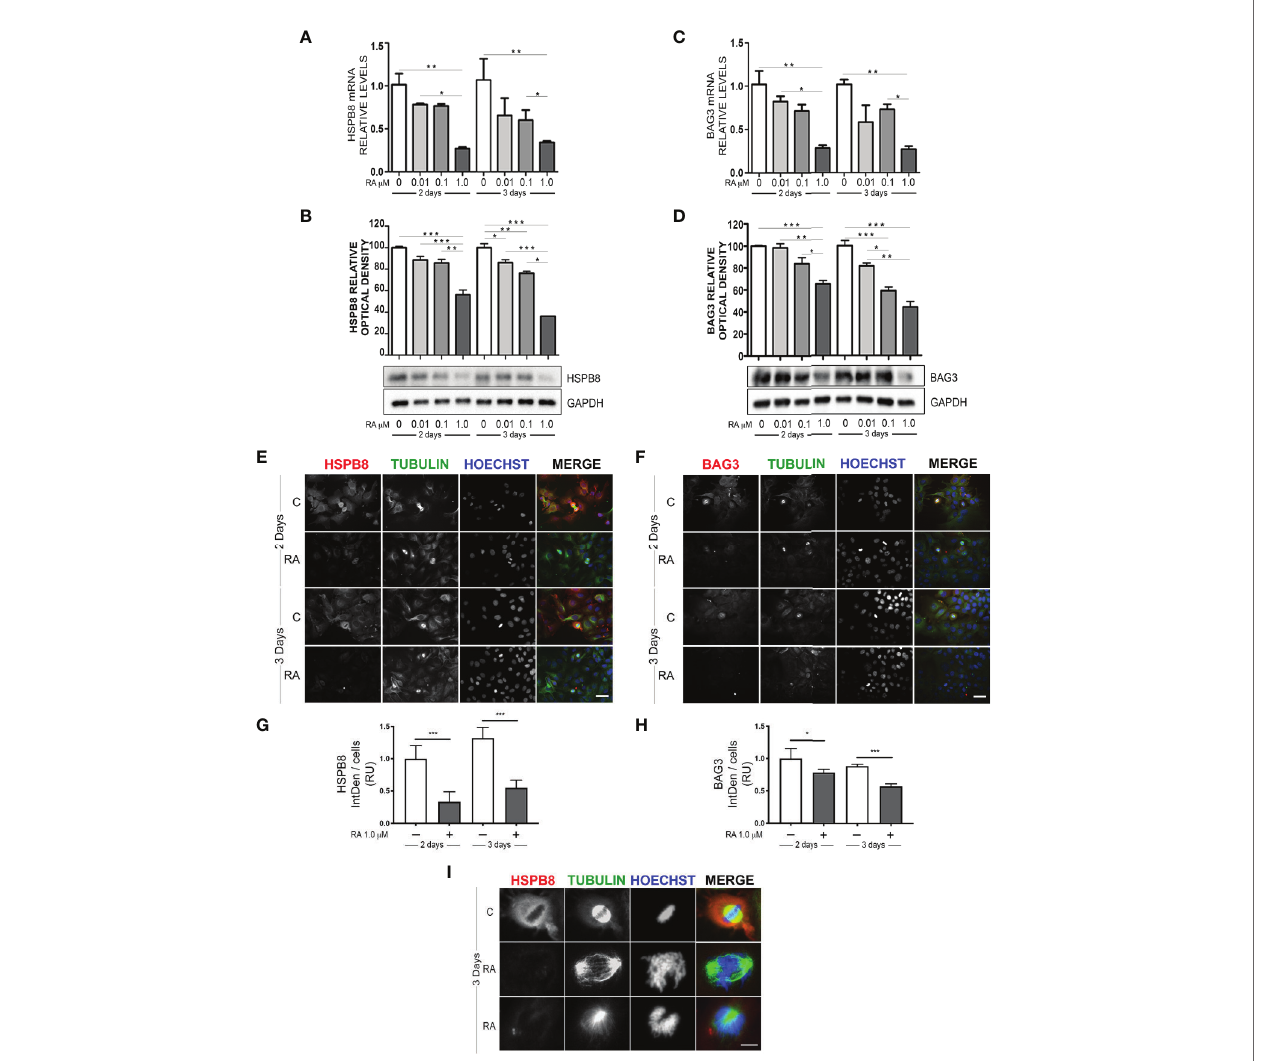
FIGURE 1 | Effect of RA treatment in MCF-7 cells. HSPB8 (A, B) and BAG3 (C, D) mRNA and protein levels measured by RT-qPCR analysis and western blot analysis in MCF-7 cells treated for 2 and 3 days with different doses of RA. (E) Immuno fl uorescence analysis of HSPB8 (red) and tubulin (green) in MCF-7 cells treated for 2 and 3 days with 1 m M RA, nuclei were stained with Hoechst (scale bar = 20 m m). (F) Immuno fl uorescence analysis of BAG3 (red) and tubulin (green) in MCF-7 cells treated for 2 and 3 days with 1 m M RA (scale bar = 20 m m). (G, H) Fluorescent intensity quanti fi cation of HSPB8 and BAG3, nuclei were stained with Hoechst. (I) Higher magni fi cation of the mitotic spindle (scale bar = 5 m m). *p < 0.05, **p < 0.01 and ***p < 0.005 in all charts. Graph bars represent the mean of three independent